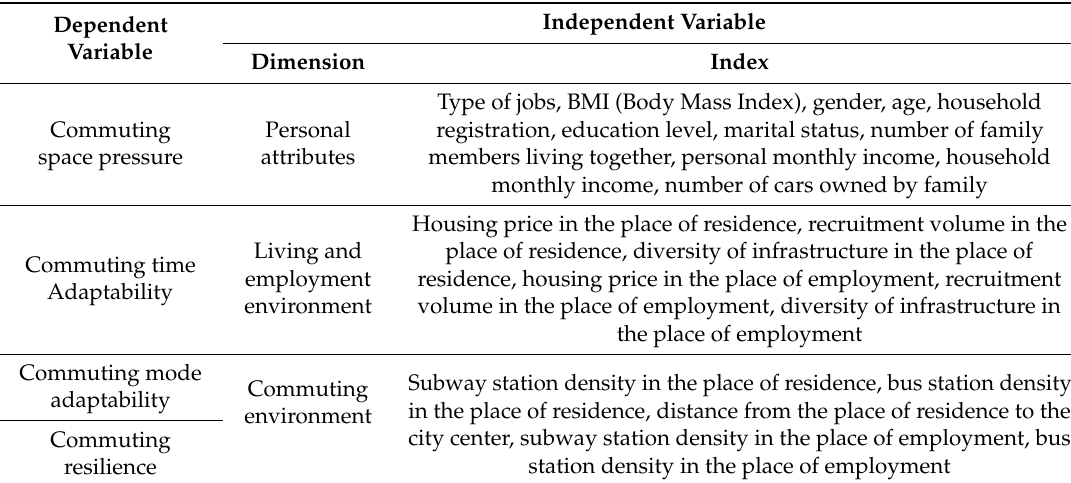
Table 4. The influencing factors system of commuting characteristics from the perspective of resilience theory.